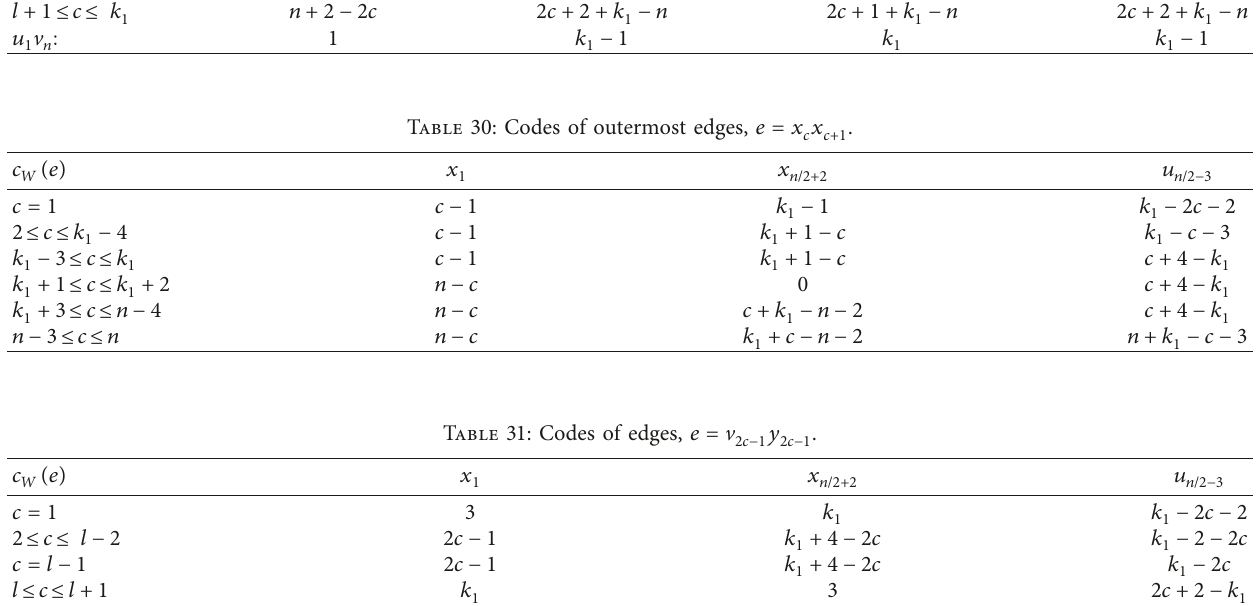
Table 29: Codes of edges, e � u